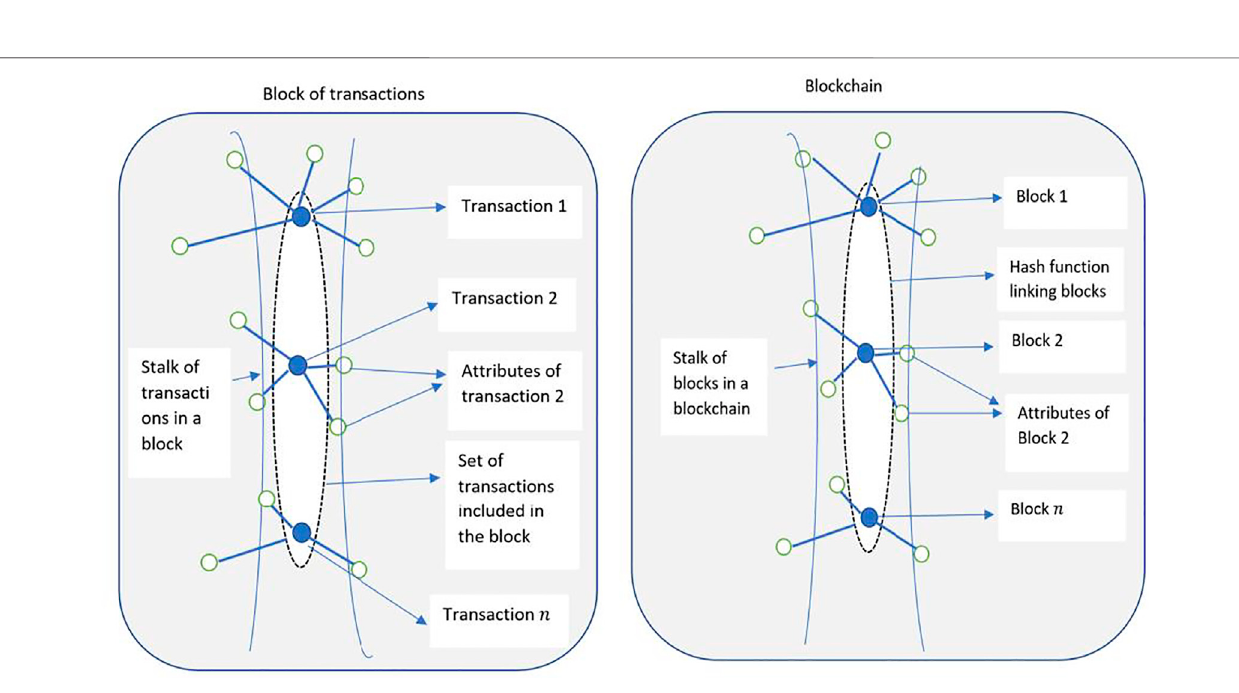
Frontiers in Robotics and AI |